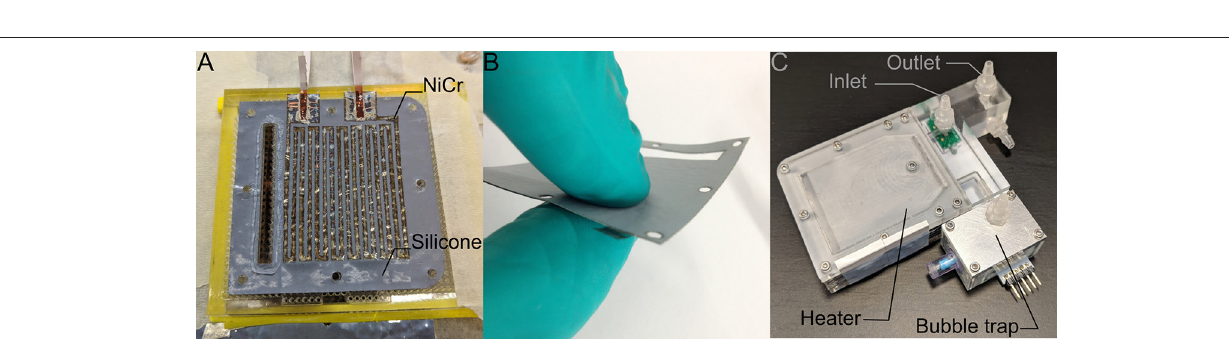
FIGURE 4 | (A) The heating elements are based on laser-cut NiCr foil sandwiched between two silicone foils. (B) The result is a watertight heating element with 0.45mm thickness. (C) The complete heater assembly includes the in- and outlet ports, five heating elements, as well as the bubble trap upstream of a valve that leads to the flow chamber. The green plate visible under the inlet port is one of the two temperature sensor breakout boards (the second one, not visible in this picture, is located within the bubble